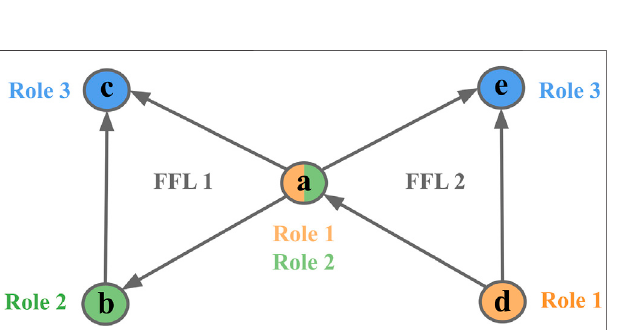
FIGURE 1 | Motif collection. The fi ve possible three-node motifs with 2 or 3 unidirectional links.